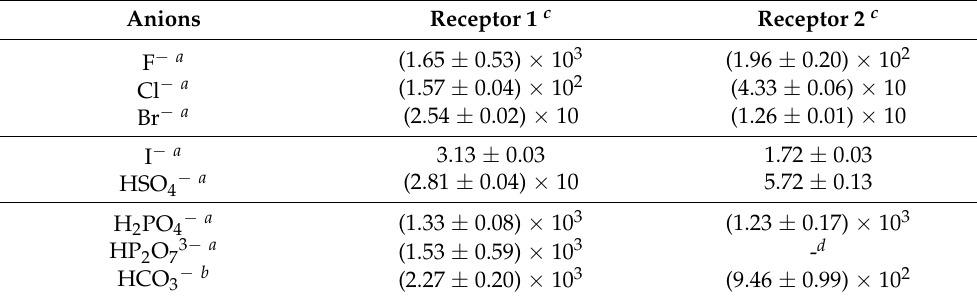
Figure 8. Top: Putative binding modes of receptor 1 for the dihydrogen phosphate anion. Bottom: Partial 1 H NMR spectra measured during the titration of receptor 1 (3 mM) with tetrabutylammonium dihydrogen phosphate (TBAH 2 PO 4 ) in CD 3 CN. Table 1. Association constants (K a , M − 1 ) of receptors 1 and 2 for the test anions as determined by 1 H NMR spectroscopic titrations in CD 3 CN at room temperature.